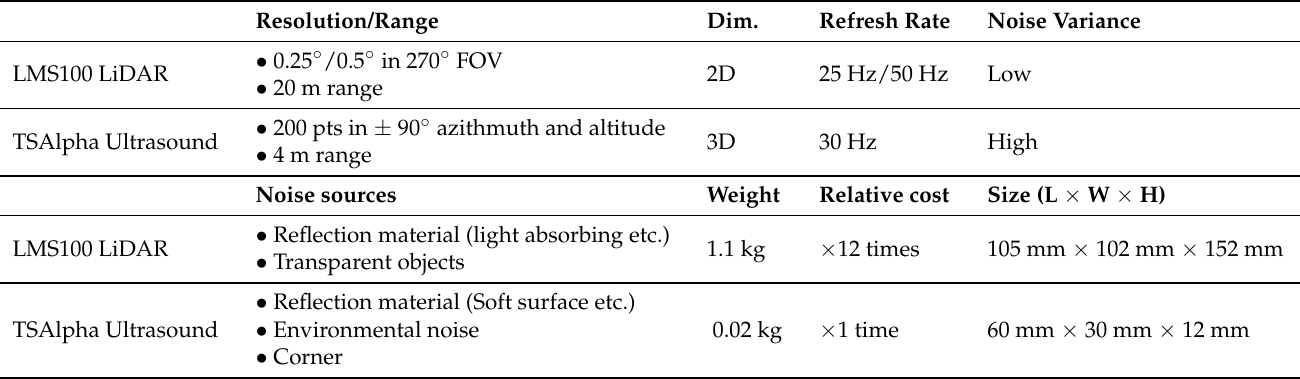
The differences between LiDAR and 3D Ultrasound are highlighted in Table 1: Table 1. Comparison between LMS100 and TS Alpha